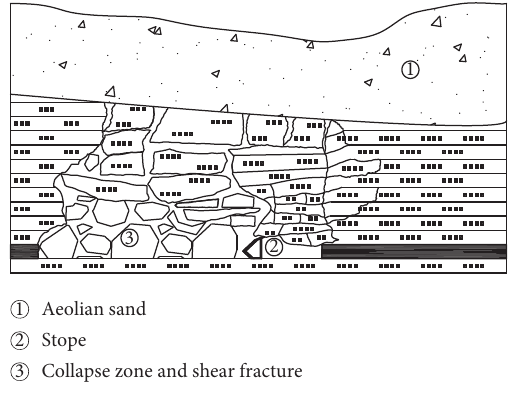
Figure 2: Fracture sand inrush model.